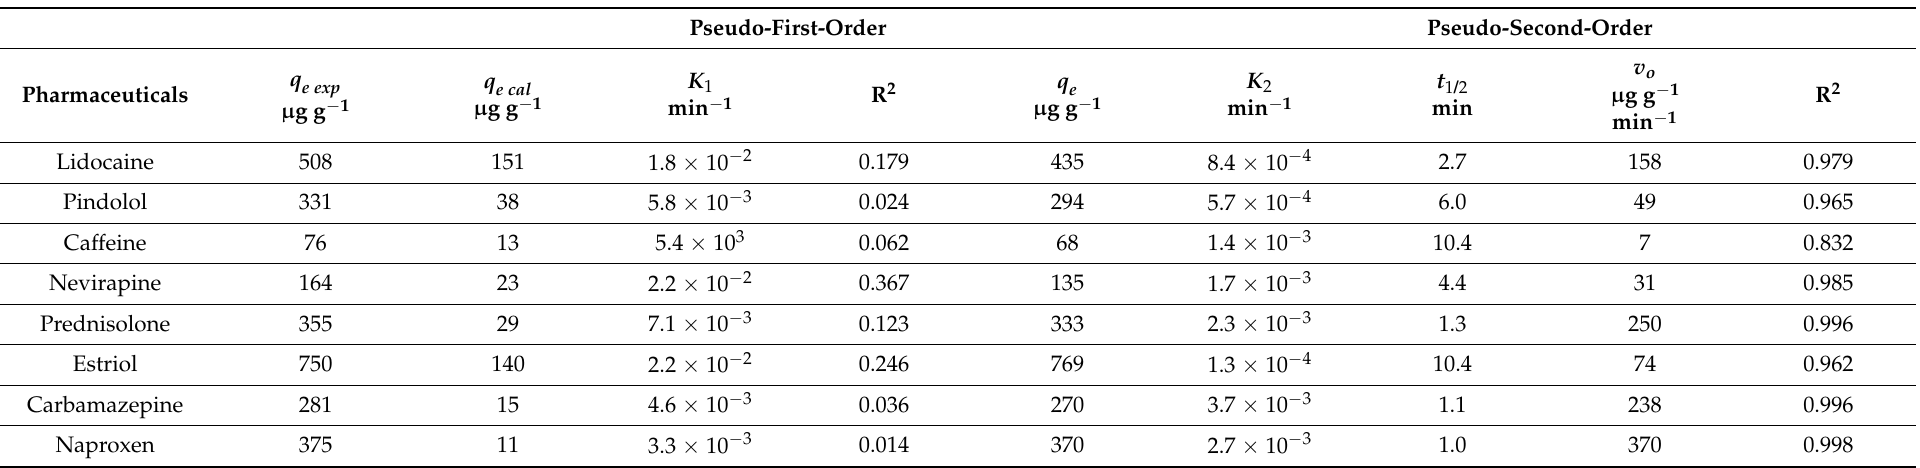
Table 2. Kinetic parameters of pseudo-first-order and pseudo-second-order.